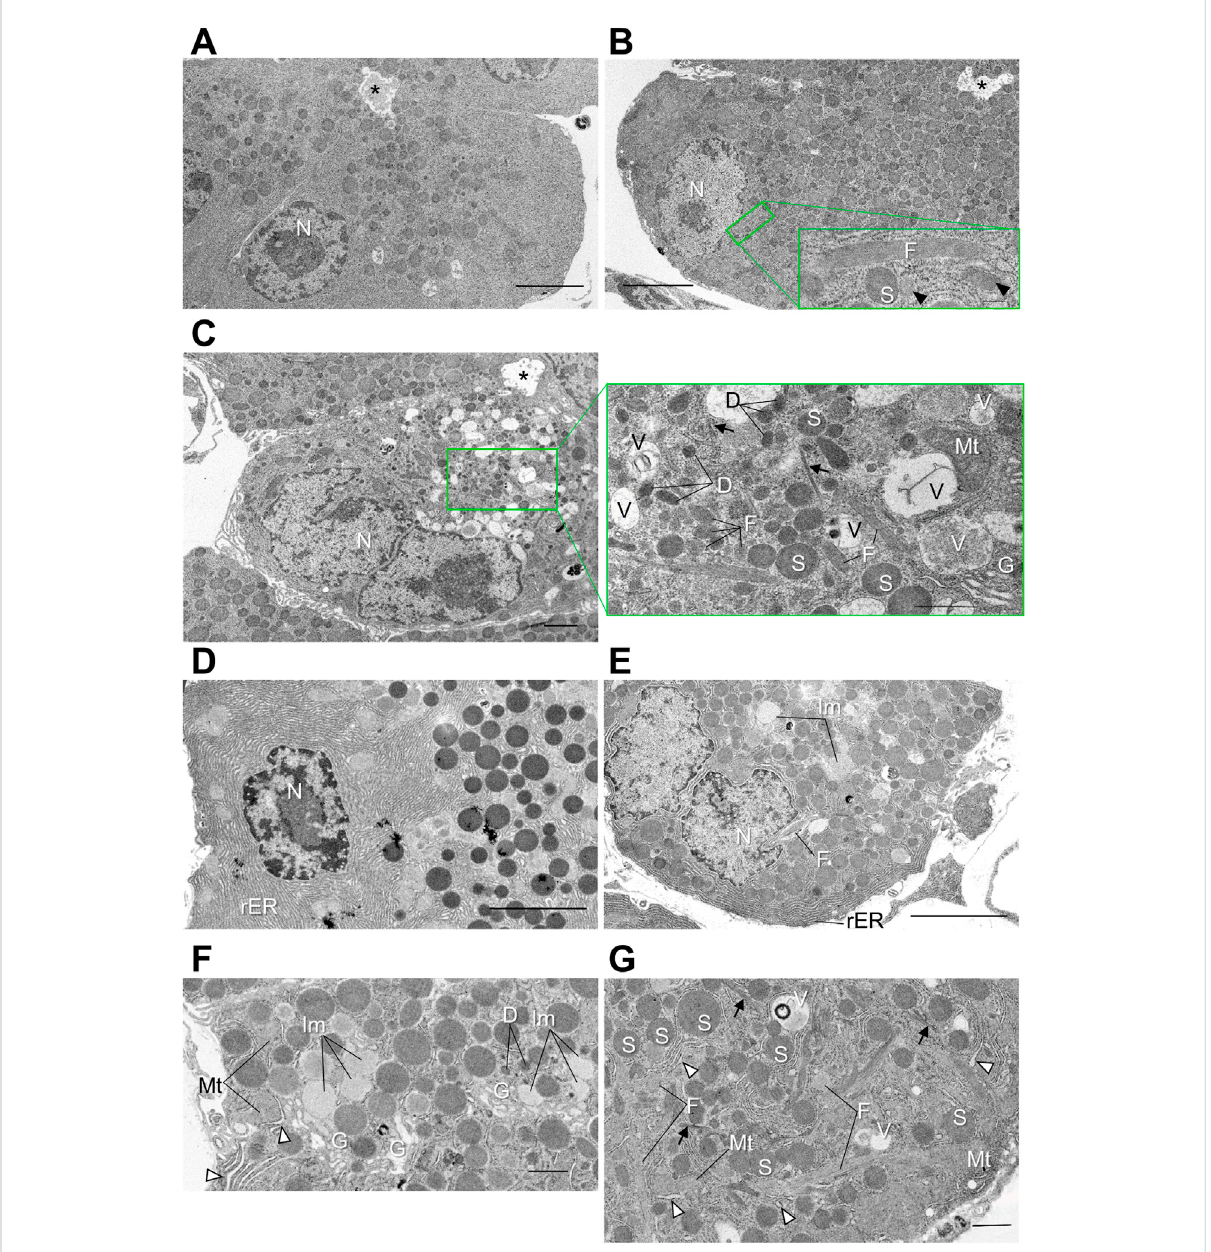
FIGURE 4 Distorted intracellular membrane structures in pancreatic acinar cells of Cadps2 -KO mice. (A – C) , Electron micrographs of pancreatic acinar cells ofWT (A) and KO (B,C) mice at2 months ofage. For KOmice, twotypesofacinar cellsare shown: In (B) , cells atan early stageof atrophy and in (C) , atrophic KO cells with disorganized cytoarchitectures at the progressed stage. Compared to WT cells (A) , excessive amounts of SGs are accumulated in the cytoplasm of KO cells (B) from the apical site facing the lumen to the basal site where the nucleus resides. Image in the bottom right corner in panel B is a high magni fi cation image of the green square containing a longitudinal section of a fi brillar granule. Arrowheads indicate transverse and oblique sections of fi brillar granules. In atrophic KO cells in (C) , round SGs are sparse. Image in the right of panel (C) is a high magni fi cation image of the green square box. Arrows indicate fi ne bundles of intermediate fi laments that are dispersed in the cytoplasm. Asterisks indicateacinarlumen.Scalebars:5 μ minAandB;200 nmin(b ’ );2 μ min (C) ;and1 μ min(c ’ ). (D – G) ,Electronmicrographsofpancreaticacinarcells ofWT (D) and KO (E – G) mice at6 months ofage.Panels (D,E) show thebasolateralareaofWT andKO, respectively. Panel (F) ishigher magni fi cation image of the Golgi area. White arrowheads indicate distensions in rER lumina. Panel (G) is high magni fi cation image of the basal section. Arrows indicatebundlesofintermediate fi laments. Whitearrowheads indicatedistensionsinrERlumina.D,darkvesicle;F, fi brillargranule;G,Golgicomplex; Im, immature granule; Mt, mitochondria; N, nucleus; rER, rough ER; S, SG; V, vacuole. Scale bars: 5 μ m in D and E; 1 μ m in (F) ; and 1 μ m in (G)